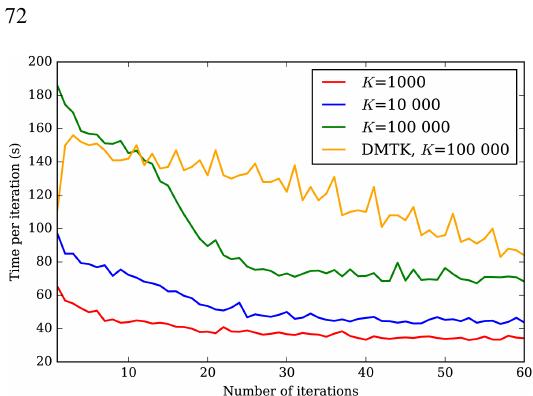
Fig. 8 Execution time per iteration as topic number varies.